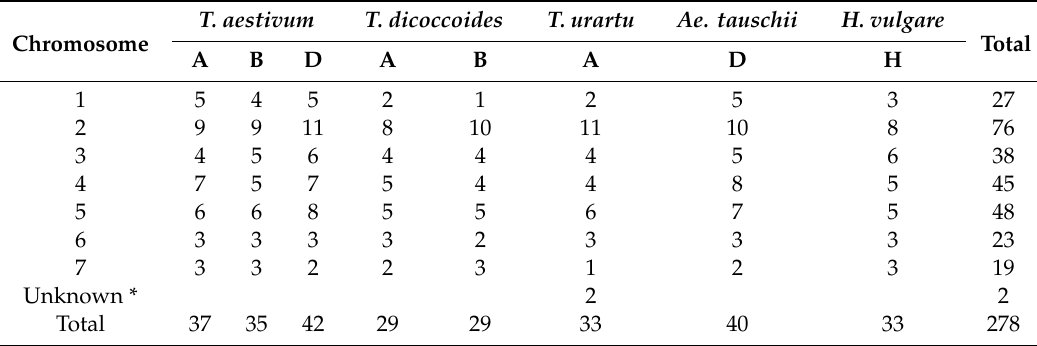
Table 1. Number of HIPPs from di ff erent species on each of the chromosomes. T. aestivum T. dicoccoides T. urartu Ae. Chromosome